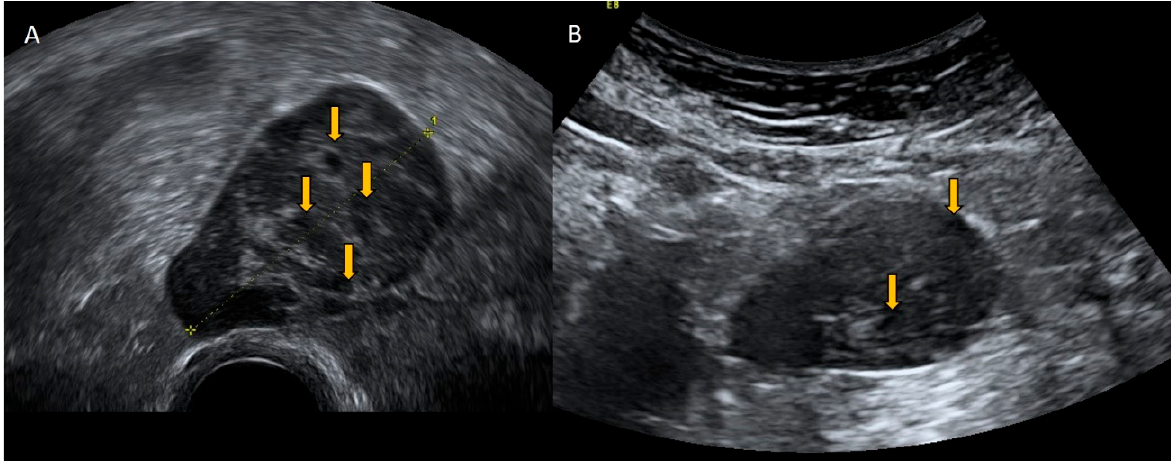
Figure 10. Transvaginal ( A ) and transabdominal ( B ) ultrasound of a patient with a GIST shows a solid pelvic tumor of mixed echogenicity with cystic areas (yellow arrows) and abundant vascularization and without acoustic shadowing.